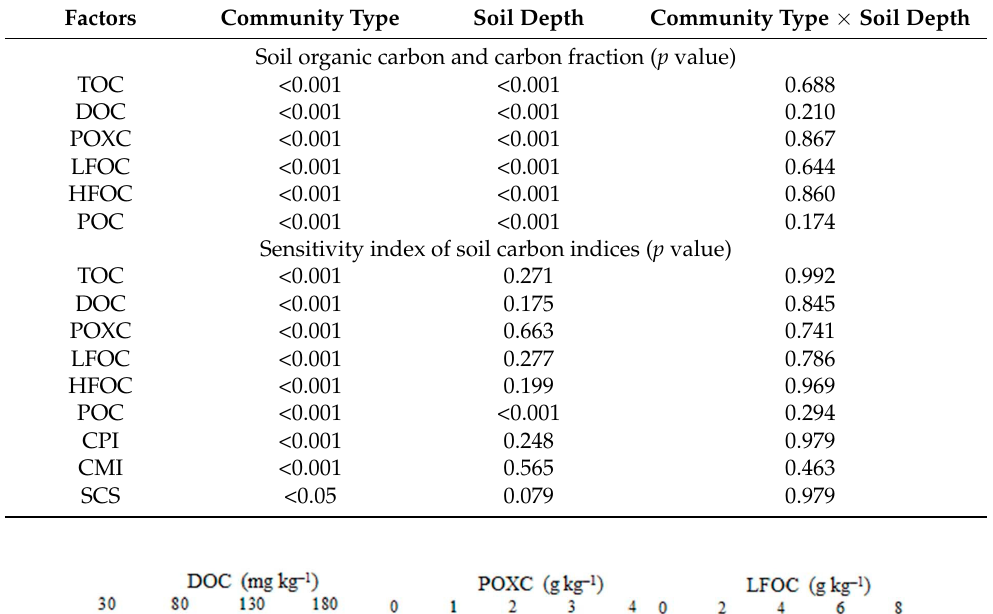
Table 1. Results of two-way ANOVA of the single and interactive effects of soil depths and vegetation types on soil organic carbon, carbon fractions, and the sensitivity indices of the soil carbon indices.